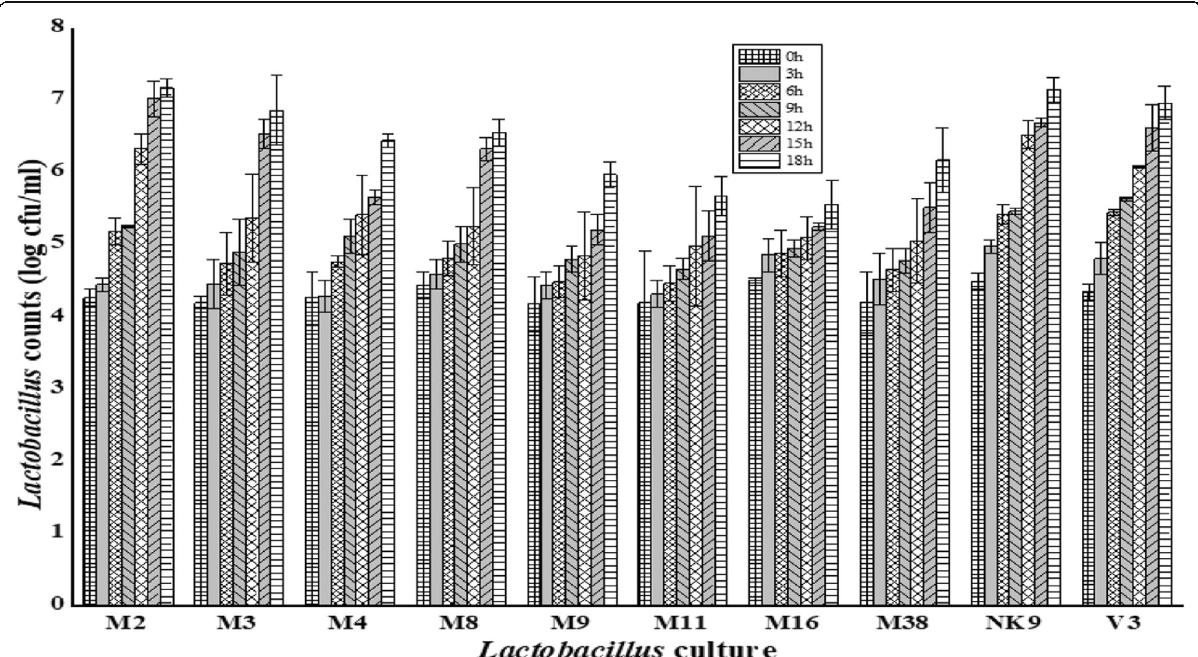
Fig. 3 Change in viable counts of Lactobacillus cultures incubated for different hours at 37 °C in soy milk medium. Values are mean ± standard deviation of triplicate determinations ( n = 3)